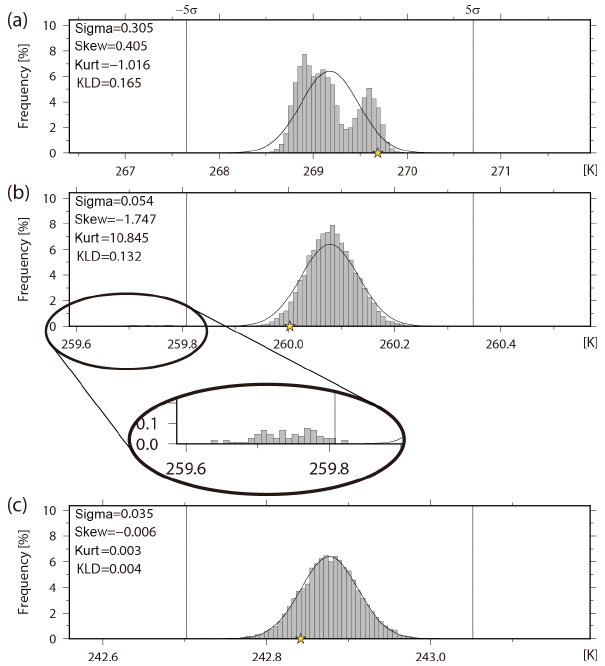
Figure 2. Histograms of background temperature (K) at the fourth model level ( ∼ 500hPa) at (a) grid point A (16.7 ◦ S, 90.0 ◦ E), (b) grid point B (35.3 ◦ N, 146.3 ◦ E), and (c) grid point C (35.3 ◦ N, 112.5 ◦ W). The yellow star shows the